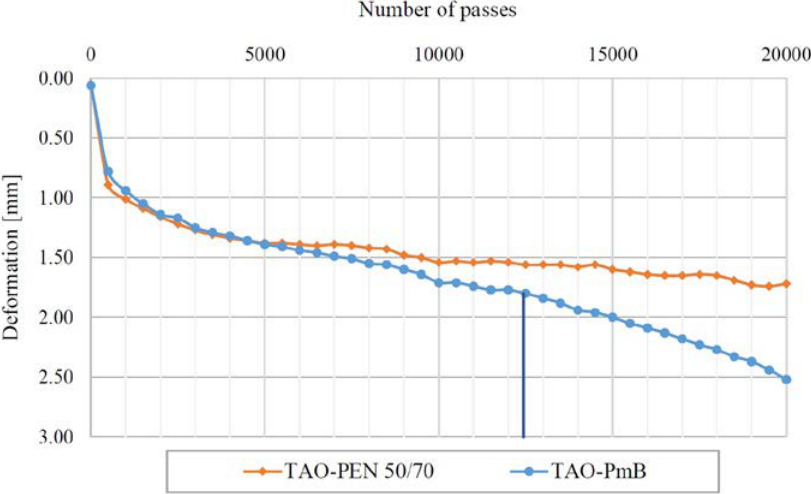
Figure 7. Rut depth of TAO–PEN 50/70 and TAO–PmB obtained from Hamburg wheel track test.